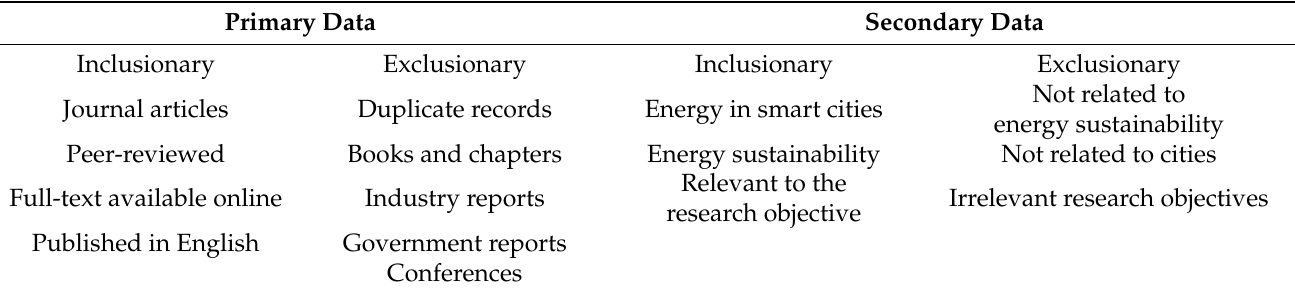
Table 1. Inclusion and exclusion